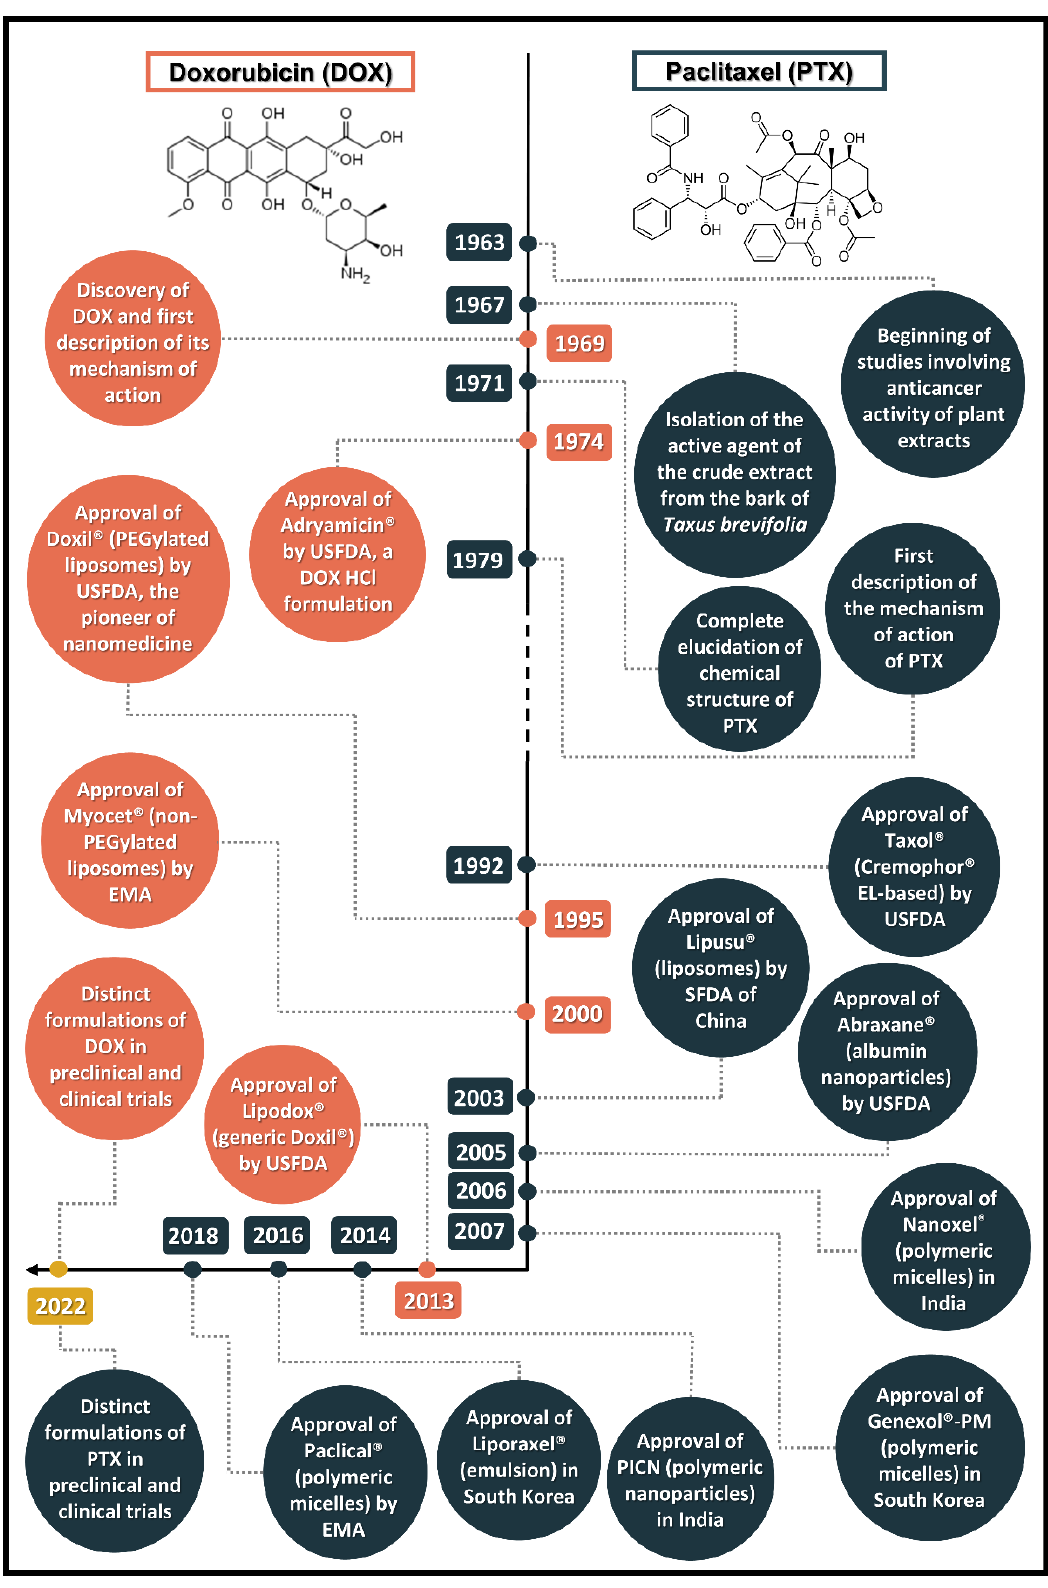
Figure 1. Research and development (R&D) timeline of doxorubicin (DOX) and paclitaxel (PTX), considering their conventional and nanotechnology-based dosage forms (USFDA—U.S. Food and Drug Administration; EMA—European Medicines Agency; SFDA—State Food and Drug